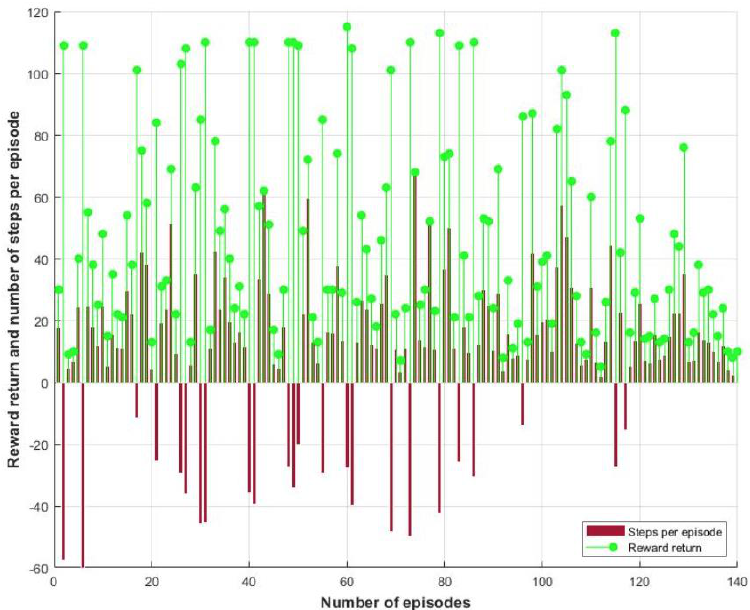
Figure 9. Accumulated reward returns per the number of steps in the first trip.